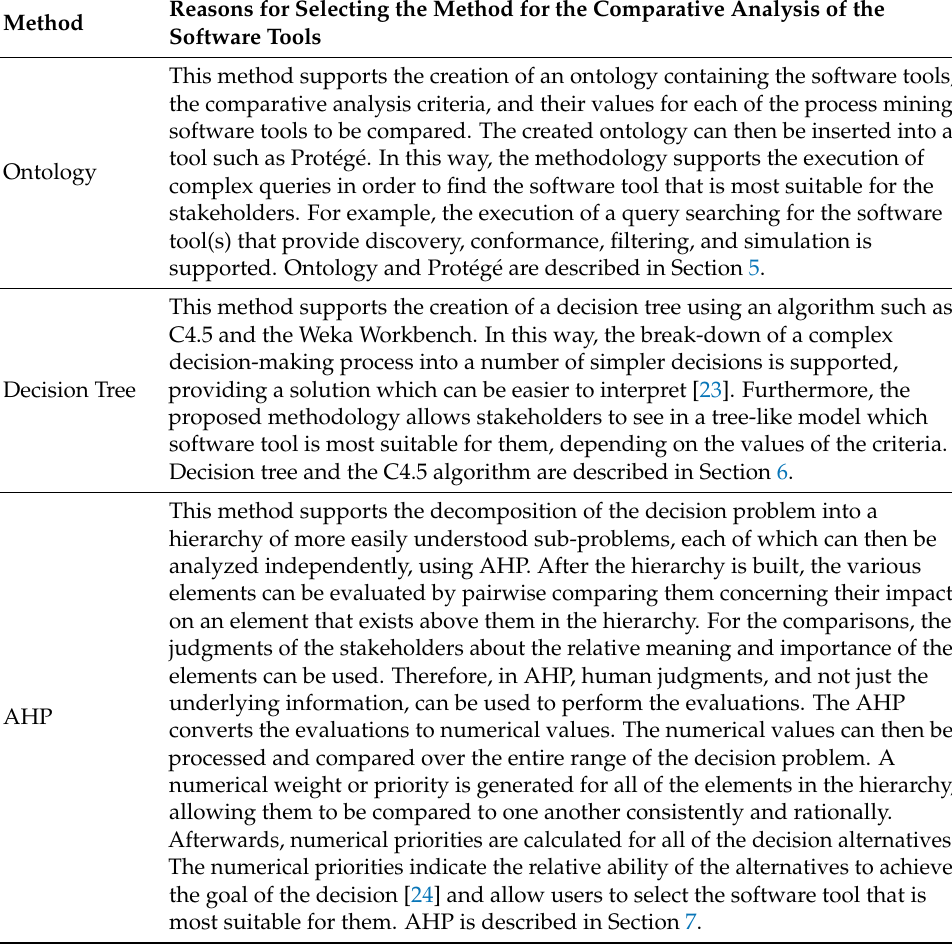
Table 3. Methods and reasons for selecting each method for the comparison of the software